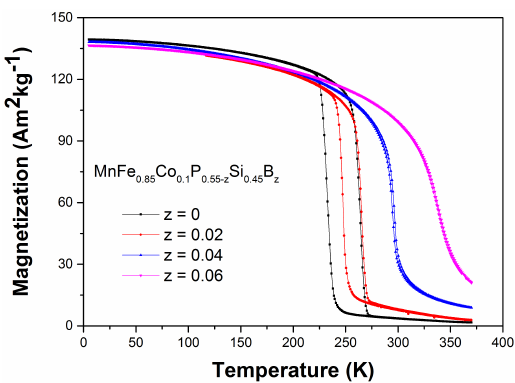
Figure 3. Magnetization as a function of temperature measured on heating and cooling in a magnetic field of 1 T for the Mn 1.00 Fe 0.85 Co 0.10 P 0.55 − z Si 0.45 B z compounds. The temperature sweep rate is 2 K/min.